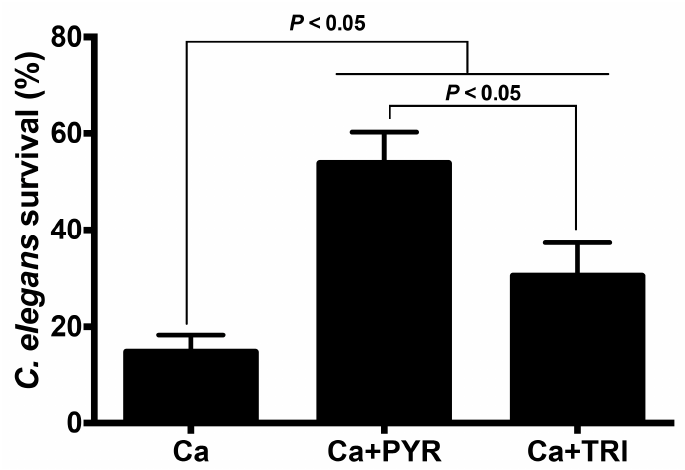
Figure 6. Effects of PYR and TRI on C. albicans virulence in C. elegans . Nematodes infected with C. albicans SC5314 strain were examined for survival daily for 4 days and the percentage nematode survival was determined on day 4. Nematodes were considered dead when they did not respond to being touched with a platinum-wire pick. Ca + PYR represents C. elegans infected with C. albicans and treated with PYR. Ca + TRI represents C. elegans infected with C. albicans and treated with TRI. Data are presented as mean ± SD of four independent measurements.